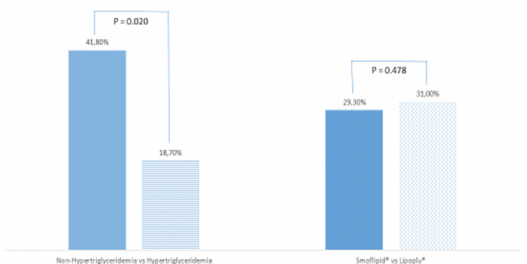
Figure 1. Mortality according to plasma triglyceride levels and lipid emulsion used. Non-HyperTG: patients with normal plasma triglycerides levels; HyperTG: patients with plasma triglyceride levels above 400 mg/dL. p -value is significant for values equal to or less than